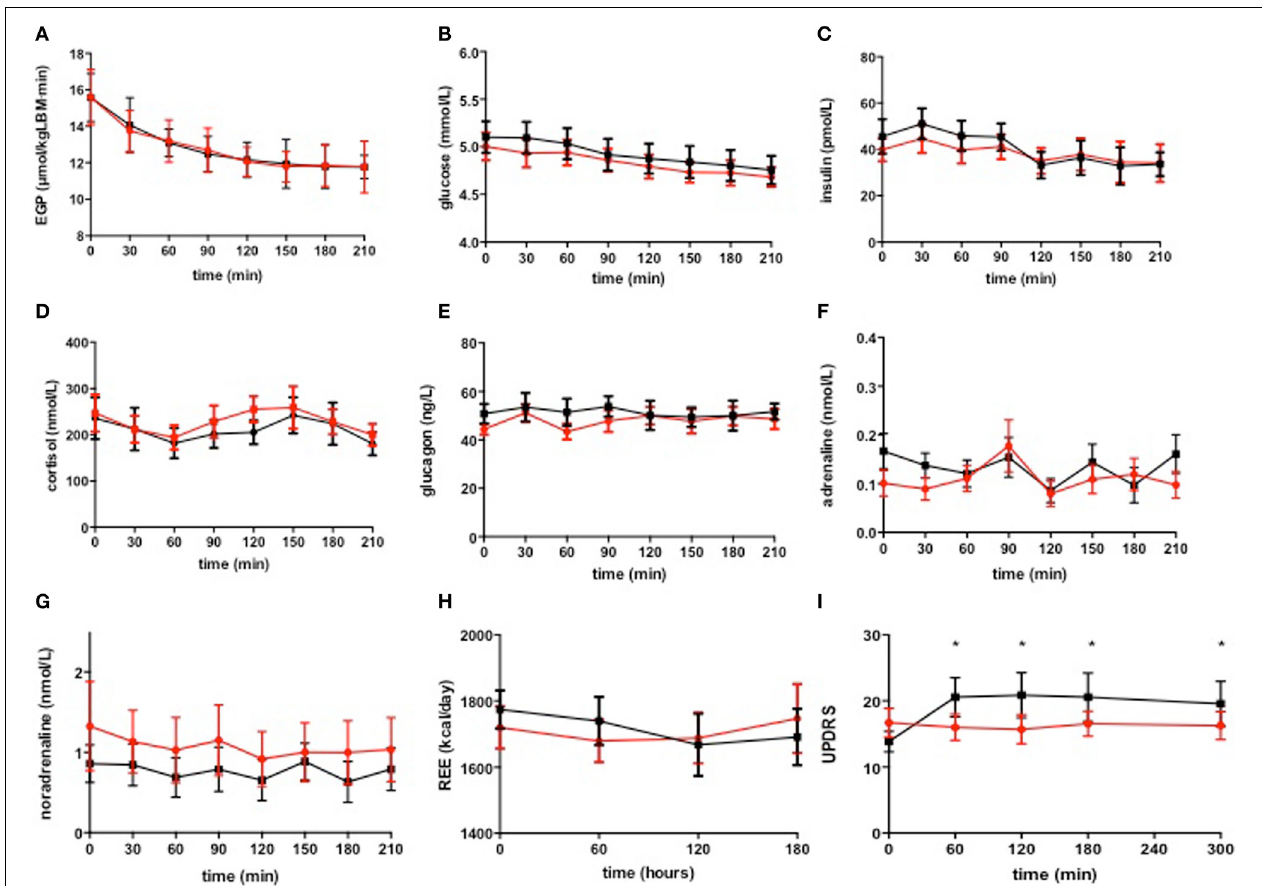
FIGURE 1 | Basal EGP (A), plasma glucose (B), glucoregulatory hormones (C–G), REE (H), and UPDRS (I). DBS switched on ( • ) and switched off ( (cid:2) ). Data are expressed as median ± s.e.m. ∗ p < 0 . 05.